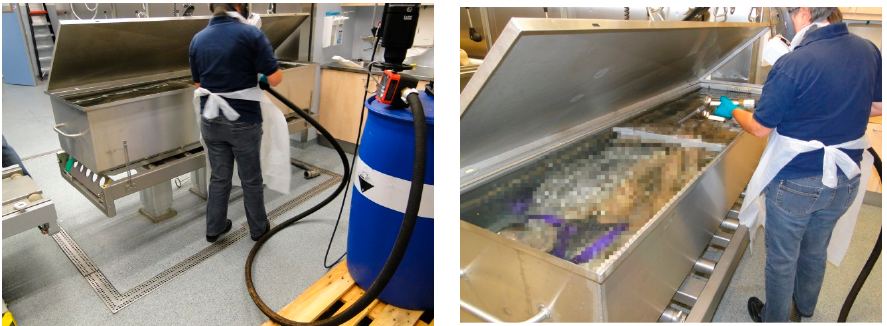
Figure 11. Refilling of a storage tank from the 37% FA concentrate. Note that the skin of the forearms is not protected.